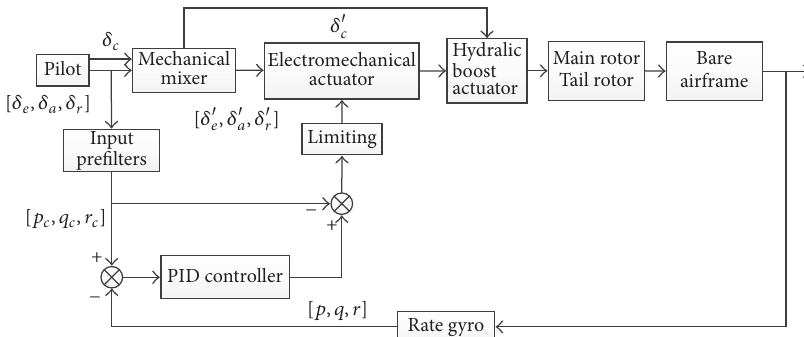
Figure 1: Implementation of RC mode into ARH-70’s PID control architecture.